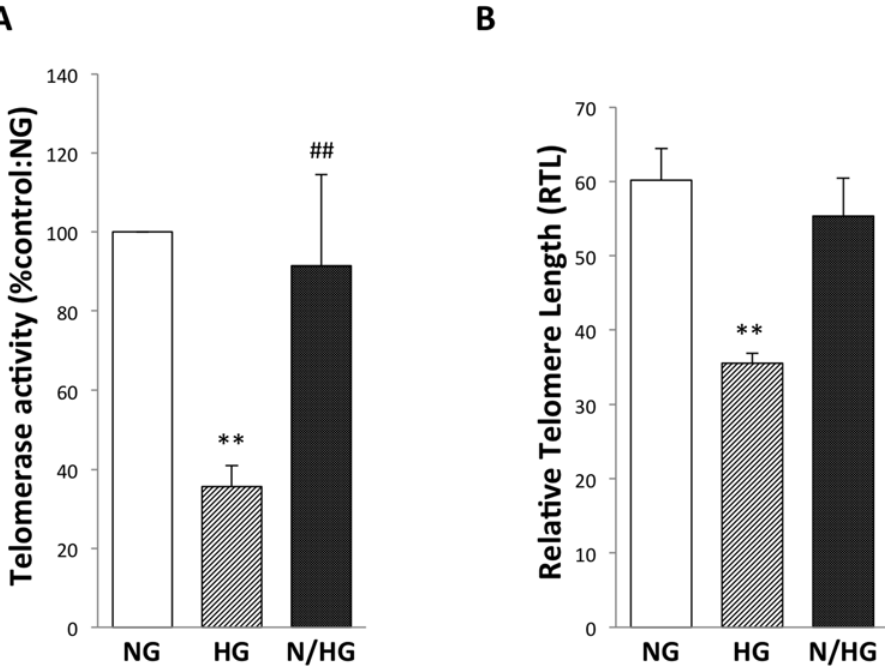
Fig 4. Effect of high glucose on telomerase activity and telomere length in HUVECs. NG, constant normal glucose (5 mM); HG, constant high glucose (22 mM); and N/HG, 5 mM alternating with 22 mM glucose. (A) Telomerase activity was measured by the telomere repeat application protocol (trap) assay. The values of the three independent experiments are mean ± S.D. ** p < 0.01 vs. NG; ## p < 0.01 vs. HG. (B) Telomere length was measured to evaluate the relationship to replicative senescence. The data shown represent the average of two independent experiments.